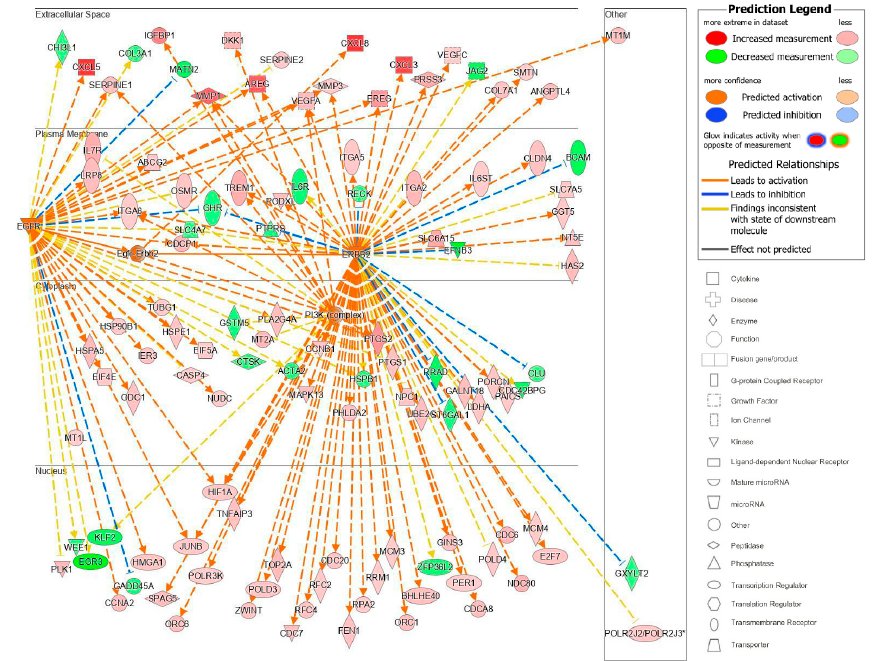
Figure 10. The Egfr–ErbB2 causal network. EGFR–ErbB2, a complex, was a master regulator with intermediate regulators EGFR, ErbB2, and PI3K (network-bias-corrected p -value 0.0001). The subcellular location and expression (red is increased, green is decreased expression) of these master and intermediate regulators and the most differentially expressed downstream target molecules in our dataset are shown. * indicates multiple identifiers in the dataset file map to a single gene in the Global Molecular Network.